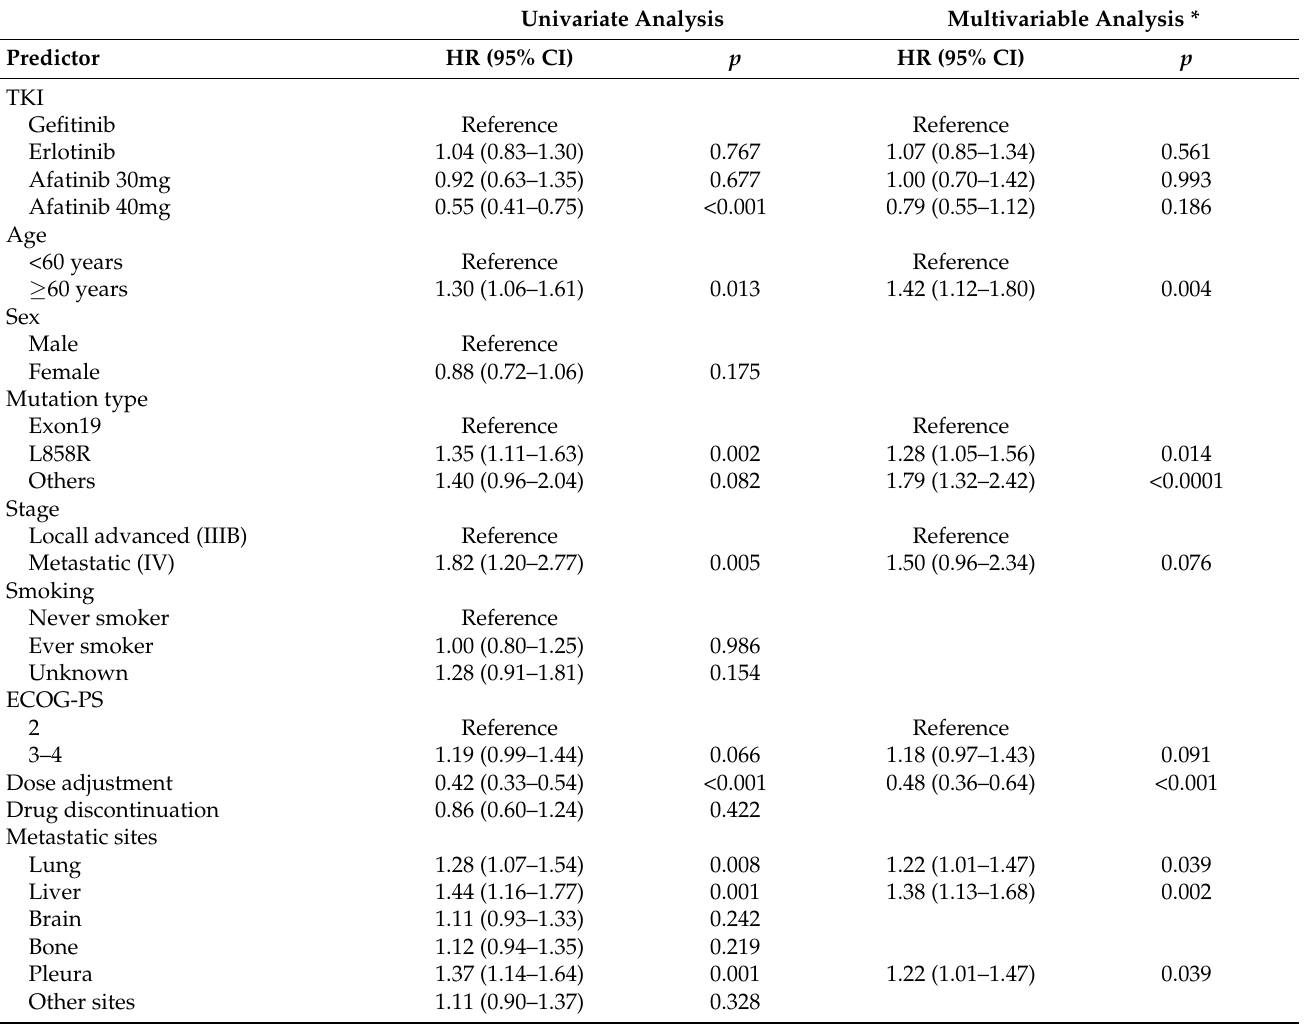
Table 3. Univariate and multivariable analysis for the associated factors with overall